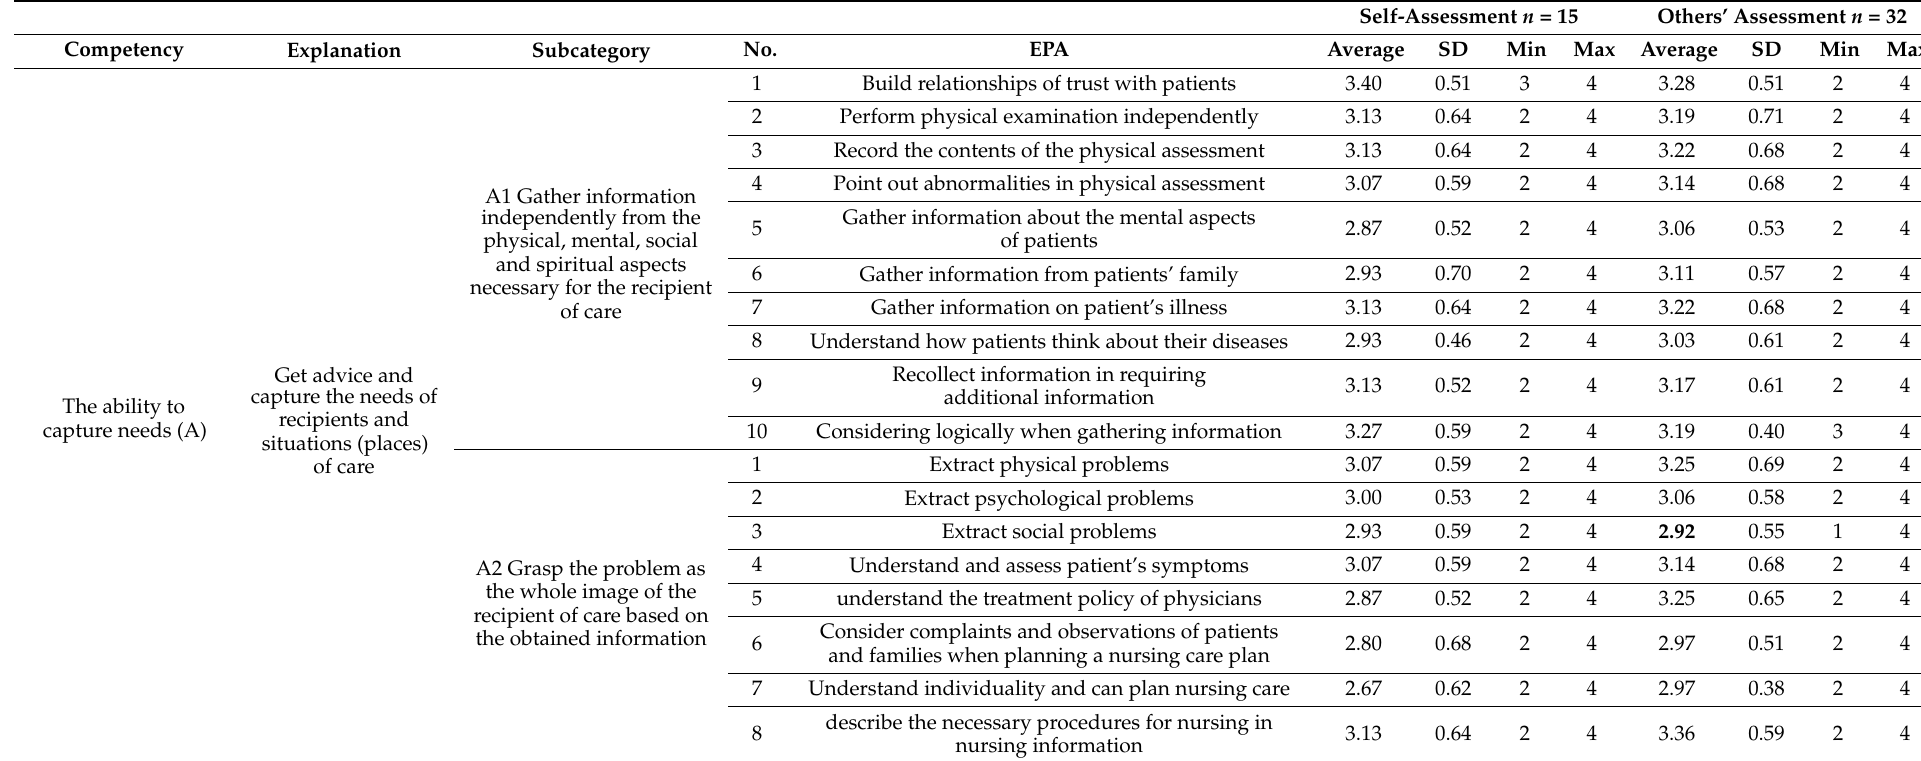
Table 1. The results of self- and others’ assessments on the “Unnan City Hospital Nurse’s Clinical Ladder” (UNNAN